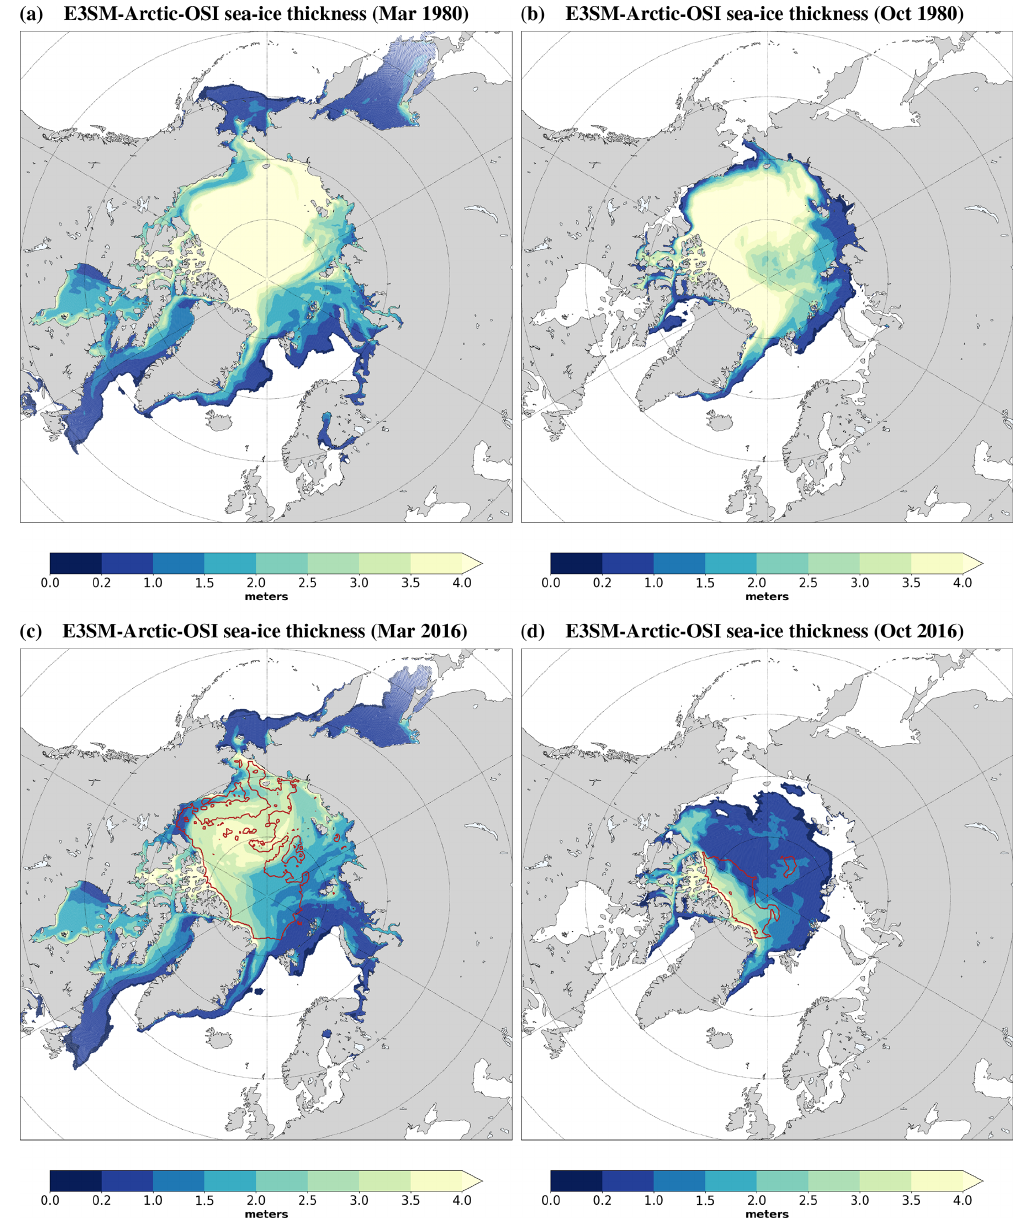
Figure 18. Maps of E3SM-Arctic-OSI sea-ice thickness for the months of (a) March and (b) October of the year 1980 (third JRA cycle), and the months of (c) March and (d) October of the year 2016 (again, from the third JRA cycle). The red contour in panels (c) and (d) indicates sea-ice thickness of 2m from the CryoSat-2 satellite data (no satellite data are available in 1980, hence the missing red contours in panels a and b